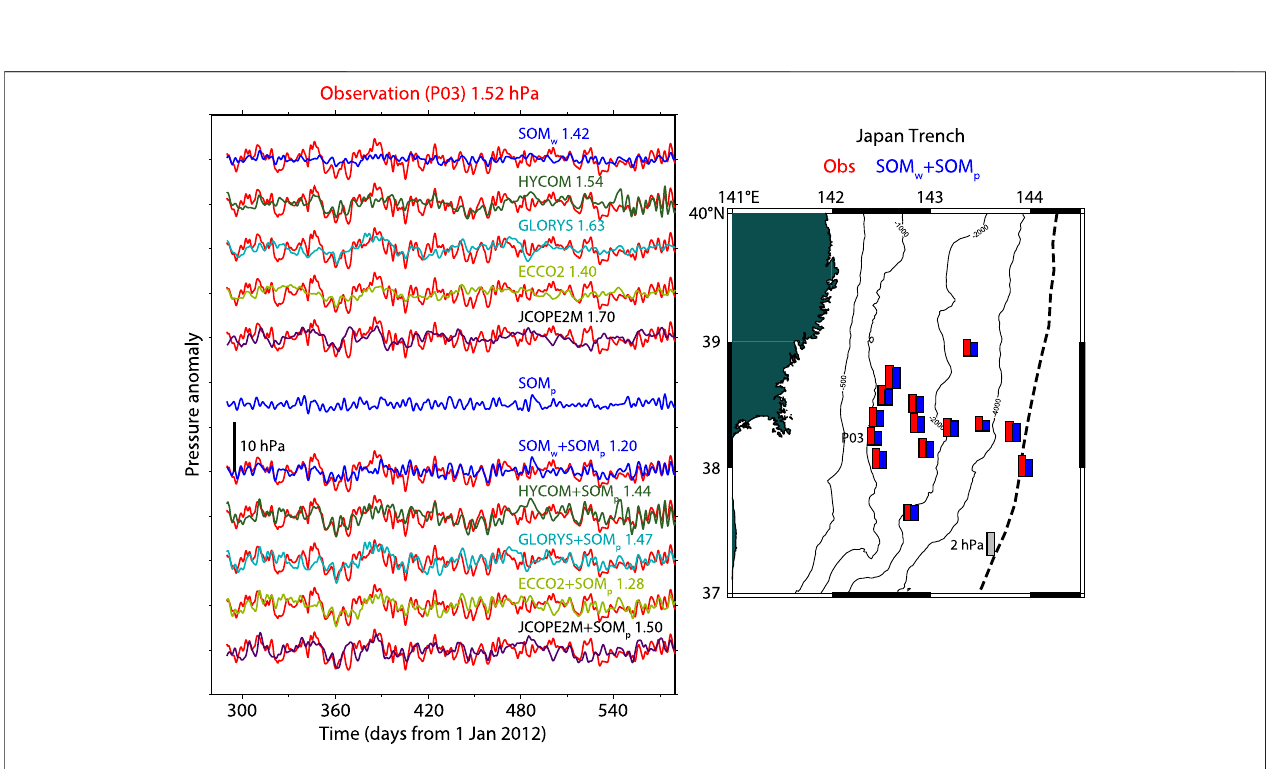
FIGURE 8 | Same as Figure 6 , but for result at P03 at the Japan Trench. Comparisons with JCOPE2M is added.